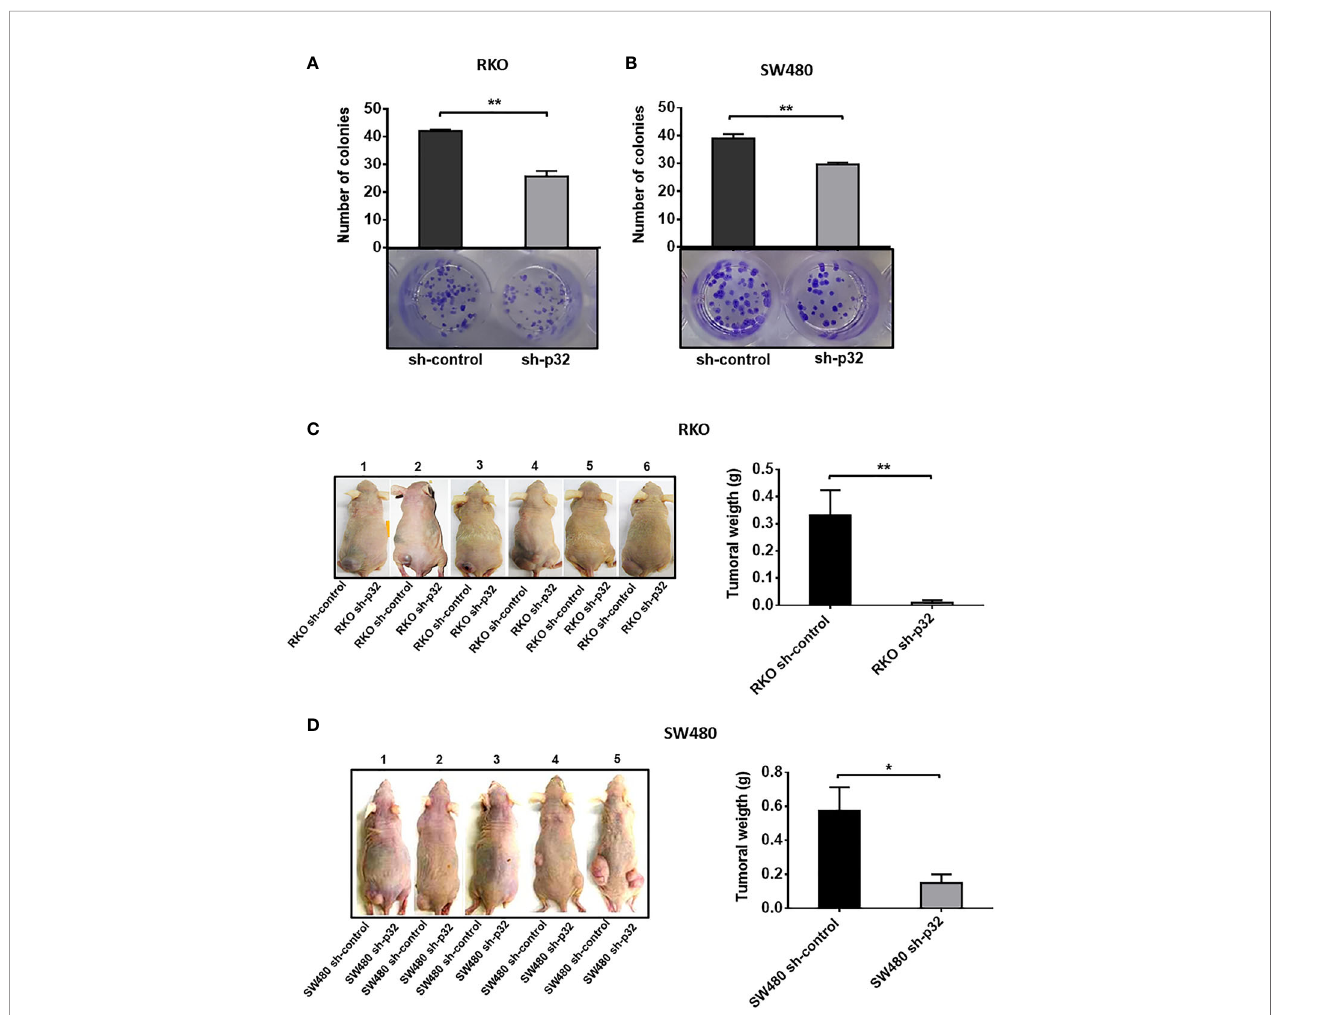
FIGURE 6 | Knockdown of p32 affects the clonogenic and tumorigenic capacity of RKO and SW480 cells. Colony formation assays for RKO sh-control and RKO-sh p32 cells (A) or SW480 sh-control cells and SW480 sh-p32 cells (B) were performed as described under the Material and Methods section. Representative photographs from 3 independent experiments are shown. The data is presented as the mean values ± SEM from three independent experiments, **p < 0.01. (C) The tumorigenic capacity of RKO sh-control and RKO sh-p32 cells was evaluated in 6 nude mice as described in the Materials and Methods section. Photographs taken of the experimental animals with tumors just after euthanasia are shown. The graph represents the mean ± SEM of the weights of tumors formed by the RKO sh-control or RKO sh-p32 cells on the 6 experimental animals, **p < 0.01. (D) The tumorigenic capacity of SW480 sh-control and SW480 sh-p32 cells was evaluated in 5 nude mice as described in the Materials and Methods section. Photographs taken of the experimental animals with tumors just after euthanasia are shown. The graph represents the mean ± SEM of the weights of tumors formed by the SW480 sh-control or SW480 sh-p32 cells on the 5 experimental animals, *p <